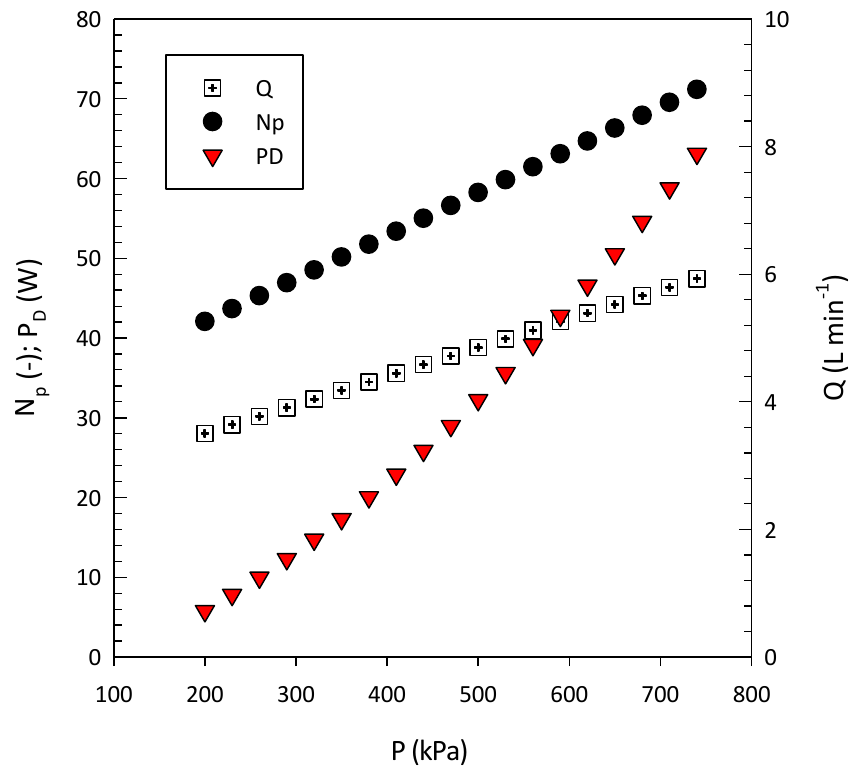
Figure 7. Number of passages N p , flow rate Q, and power dissipated P D into the experimental pilot plant vs. inlet pressure P in.